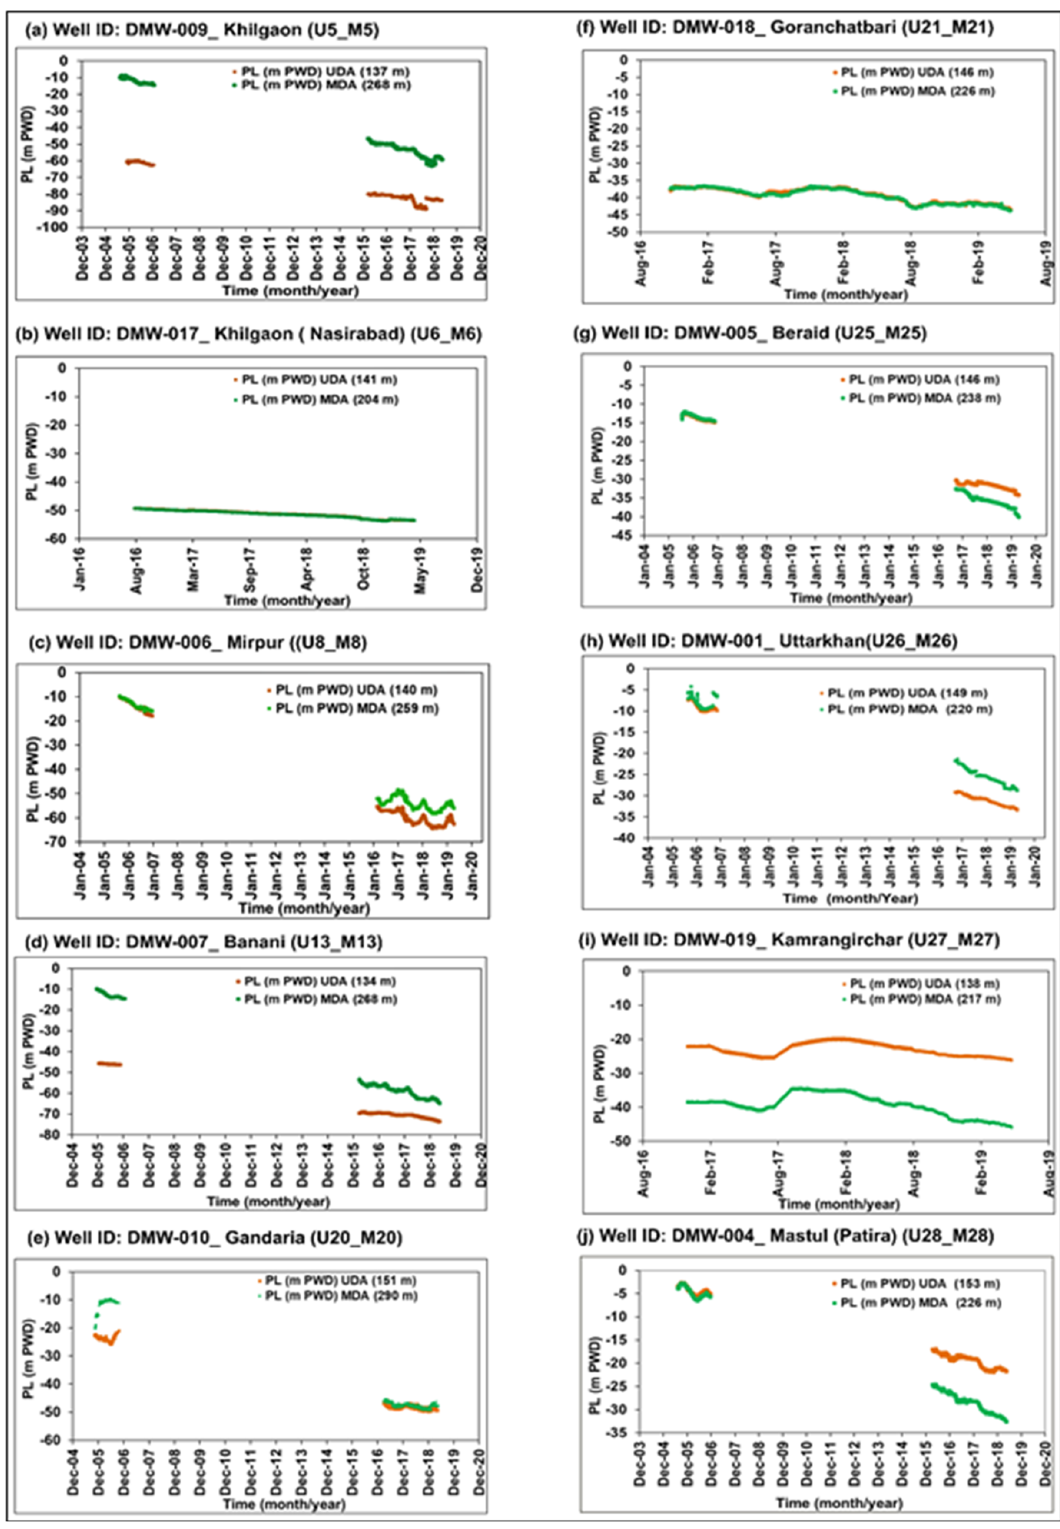
Figure 9. Long-term hydrographs of twin monitoring wells in Dhaka city. ( a ) Well ID: DMW-009_Khilgaon (U5_M5), ( b ) Well ID: DMW-017 Khilgaon ( Nasirabad) (U6_M6), ( c ) Well ID: DMW-006 Mirpur ((U8_M8), ( d ) Well ID: DMW-007 Banani (U13_M13), ( e ) Well ID: DMW-010 Gandaria (U20_M20), ( f ) Well ID: DMW-018 Goranchatbari (U21_M21), ( g ) Well ID: DMW-005 Beraid (U25_M25), ( h ) Well ID: DMW-001_ Uttarkhan(U26_M26), ( i ) Well ID: DMW-019_ Kamrangirchar (U27_M27), ( j ) Well ID: DMW-004_ Mastul (Patira)